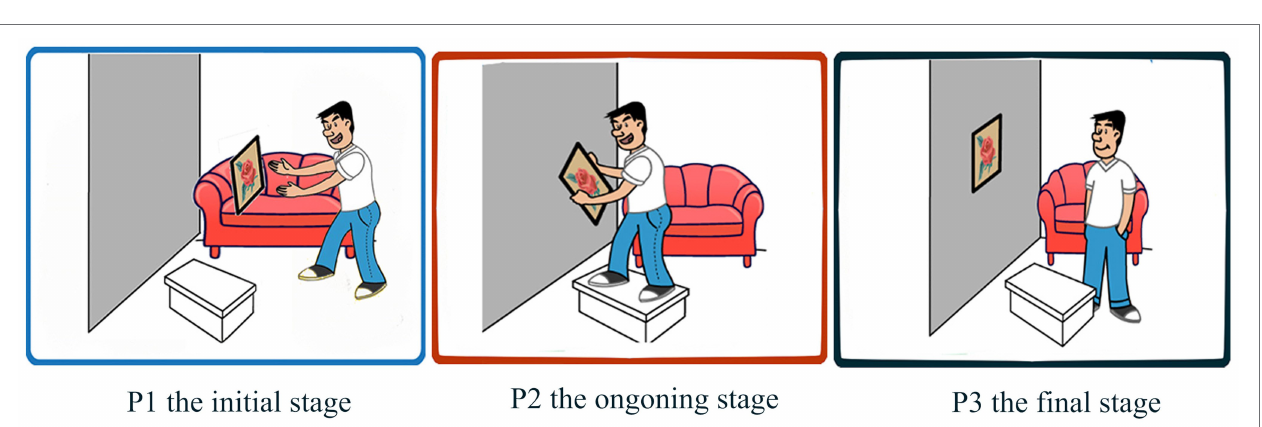
FIGURE 2 | Example for the aspect marker - zhe .